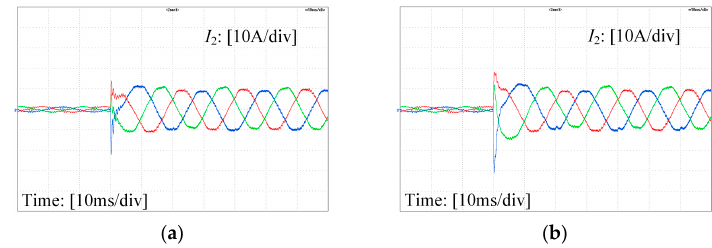
Figure 21. Grid-connected converter starting in rectifier mode with DFPS-CVFF when grid inductance L ’g = 0; ( a ) K 1 f = 0.75, K 2 f = 0; ( b ) K 1 f = 0.25, K 2 f = 0.